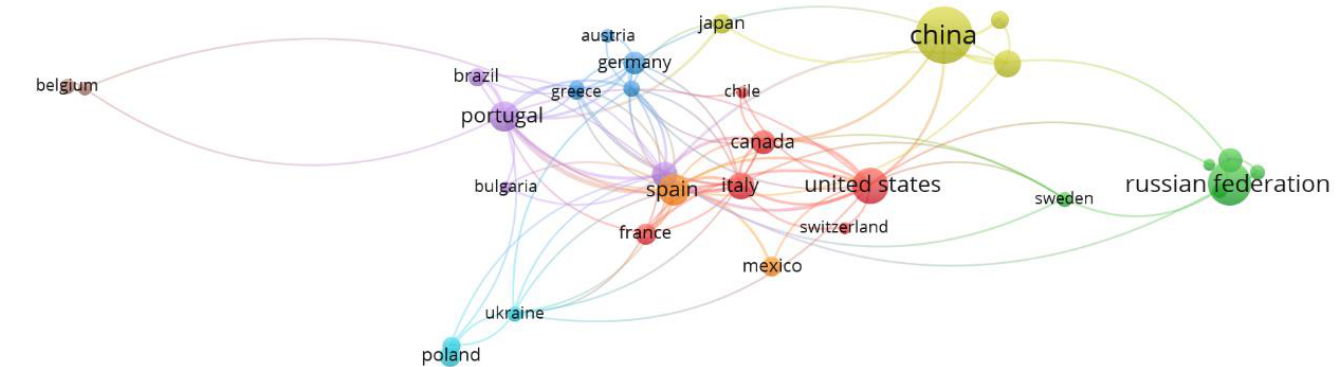
Figure 9. Distribution of articles by country in Scopus and WoS. Source: Authors’ own data. Table 8. Most productive institutions with authors and